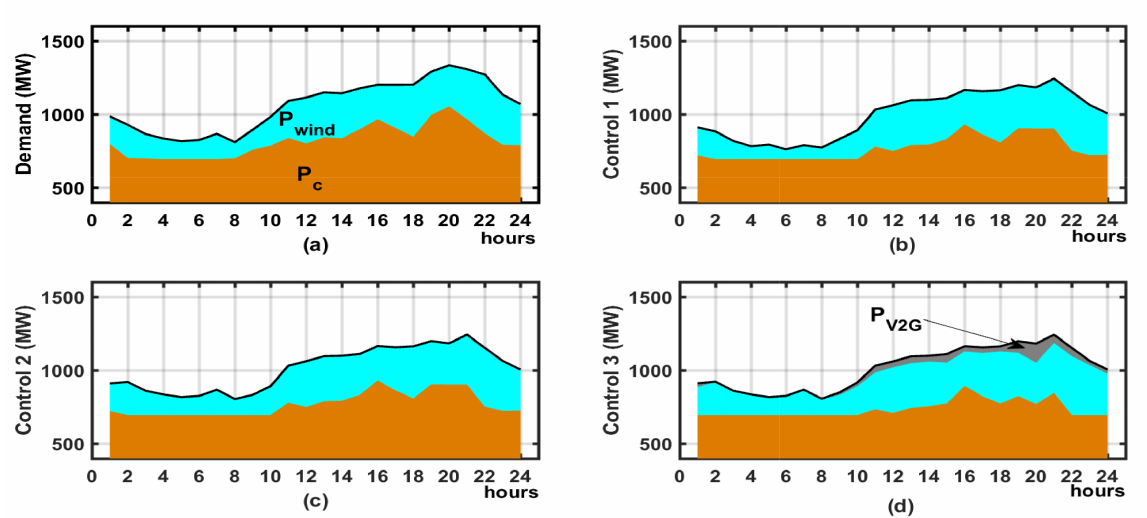
Figure 7. (Case 1) Demand and generation mix for: ( a ) w/o Control; ( b ) Control 1; ( c ) Control 2; and ( d ) Control 3.